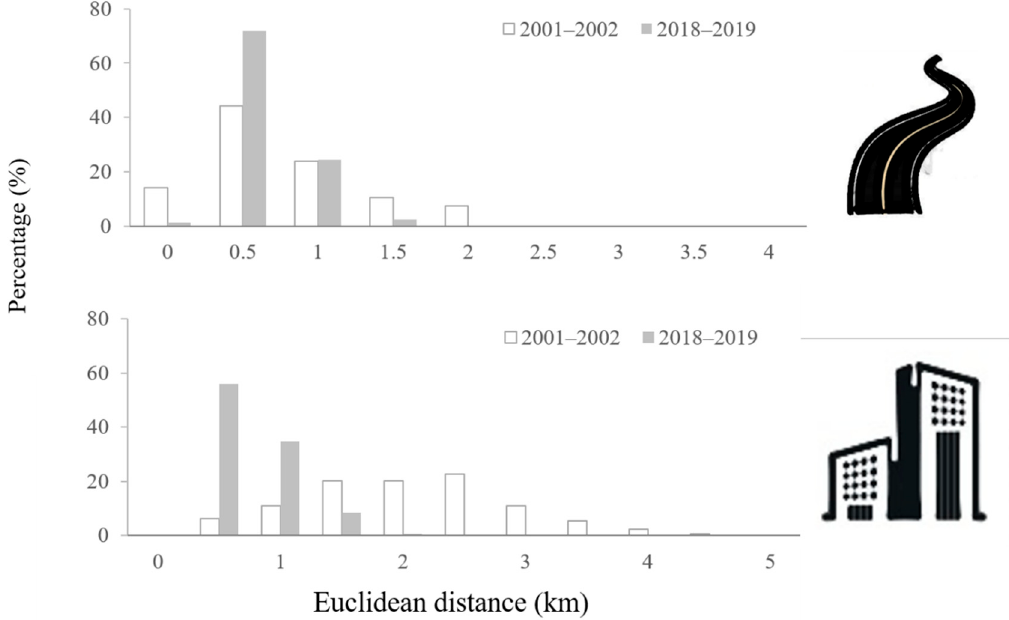
Figure 5. Frequency distribution of the distance to the nearest road and building of Reeves’s pheasant presence loca- tions.